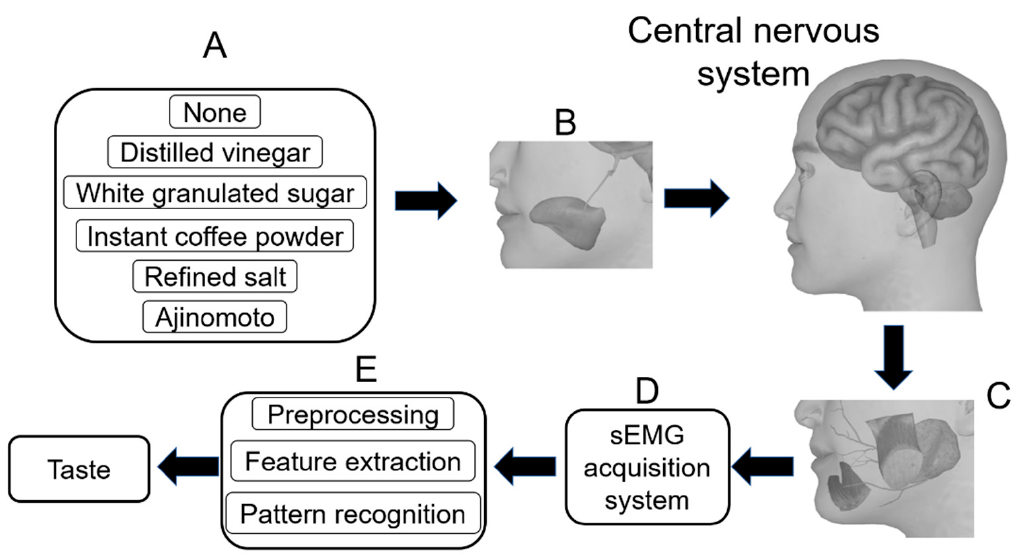
Figure 1. Schematic diagram of the study. ( A ) We used taste substances to provide 6 types of taste. ( B ) The tongue was stimulated by taste substance and taste information was transmitted to the central nervous system via the lingual nerve, mandibular nerve, etc. ( C ) Information was transmitted to muscles (masseters, depressor anguli oris, and depressor labii inferioris) and glands (parotid glands) via the facial nerve. ( D ) The activity of muscles and glands was recorded as sEMG by an acquisition system. ( E ) The sEMG signals were preprocessed, feature extracted, and pattern recog- nized.